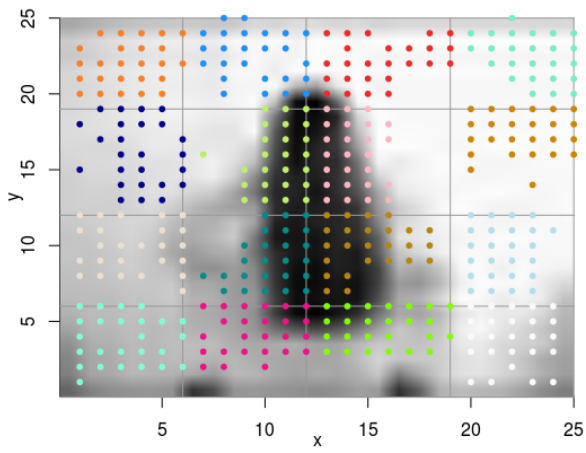
Figure 4. Selected pixels